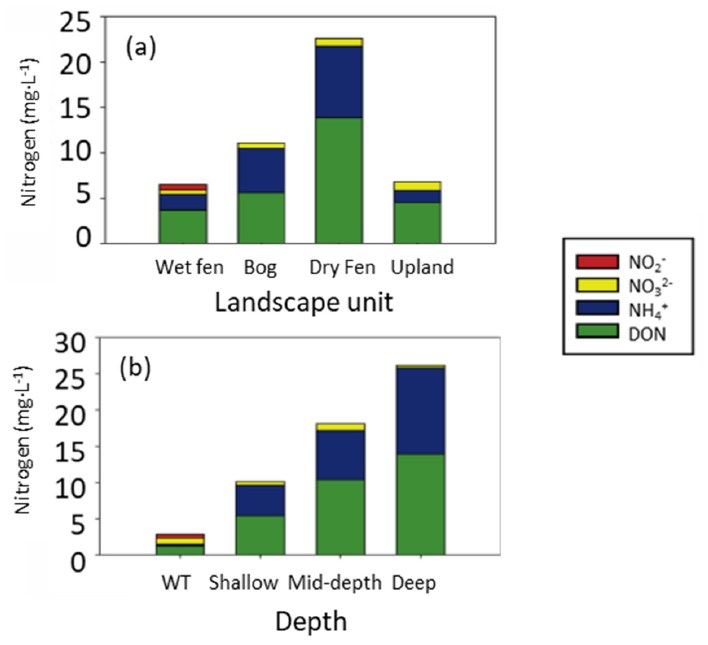
Figure 9. Summary of average nitrogen concentrations observed at ML by ( a ) landscape unit and ( b ) depth (modified after [25]).